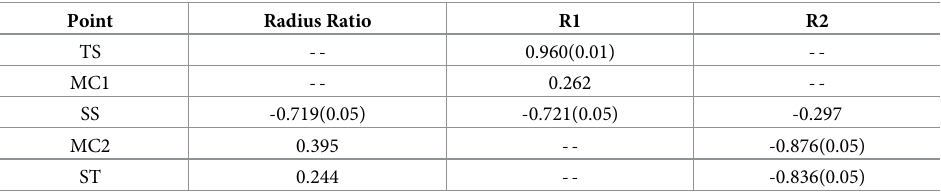
Table 8. Correlation analysis of D of s-shape curves